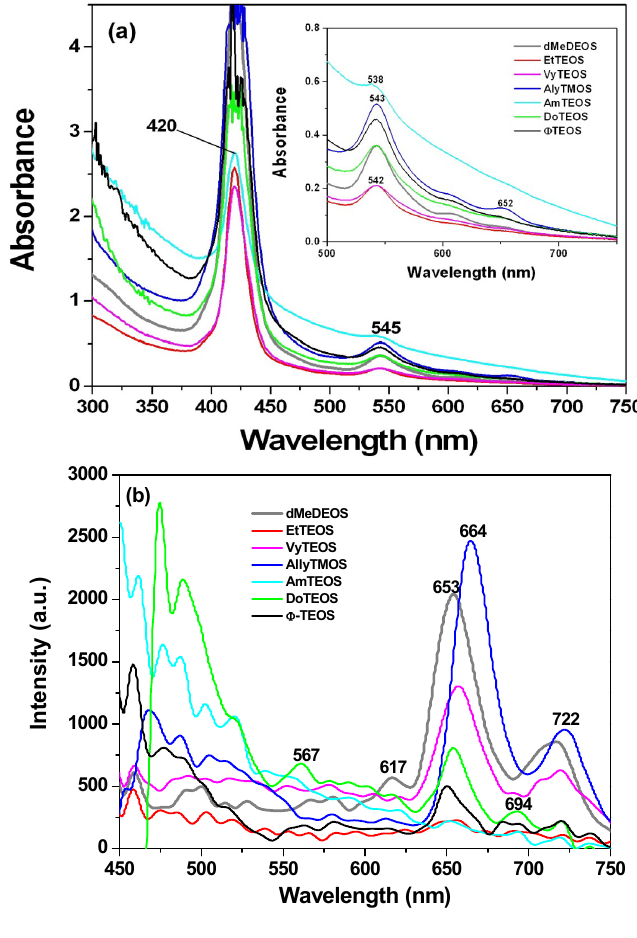
Figure 9. ( a ) Absorption spectra of H walls of silica modified with organic groups and the respective fluorescence spectra resulting from using excitation light of ( b ) 420 nm and ( c ) 370